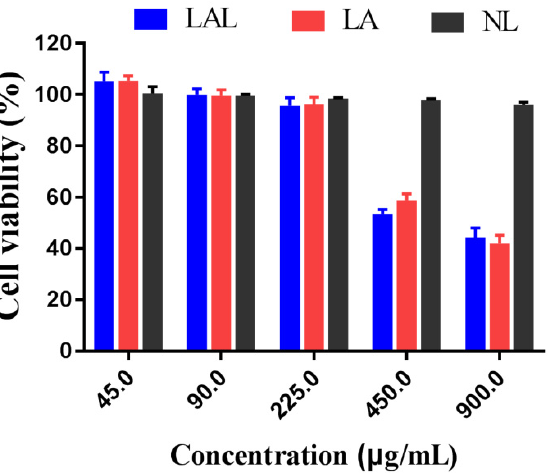
Figure 5. B16F10 cell viability after treatment with LAL, LF, and NL formulations for 24 h ( n = 6).